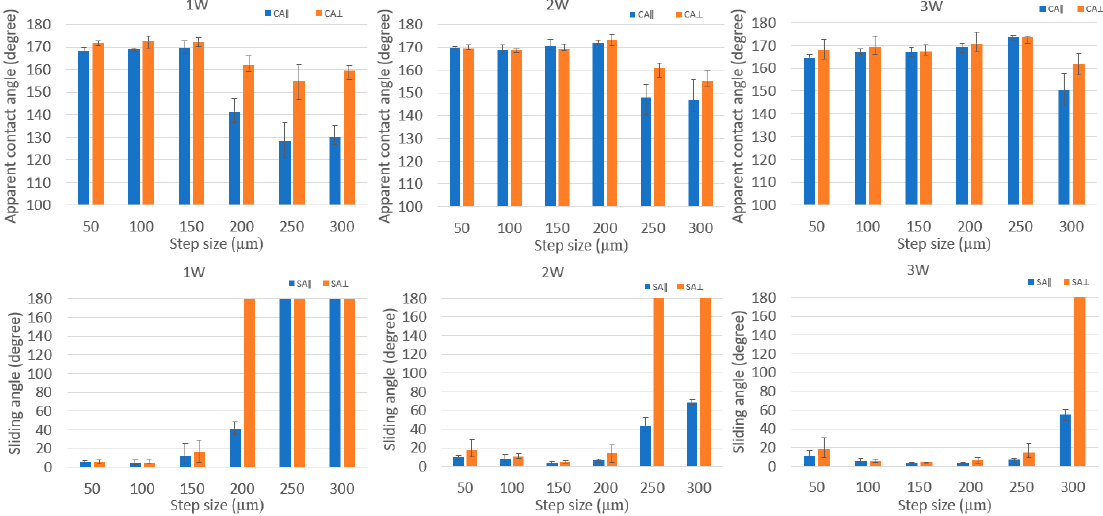
Figure 12. Apparent contact angle and sliding angle for the line pattern 35 days after heat treatment.